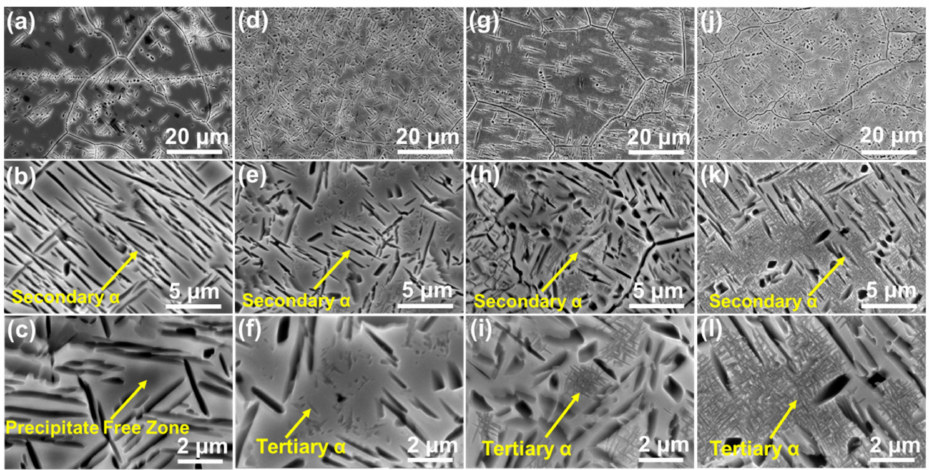
Figure 5. Microstructures of the alloy after HLDA for different time at 500 ◦ C: ( a – c ) 5 min, ( d – f ) 0.5 h, ( g – i ) 2 h, ( j – l ) 4 h.